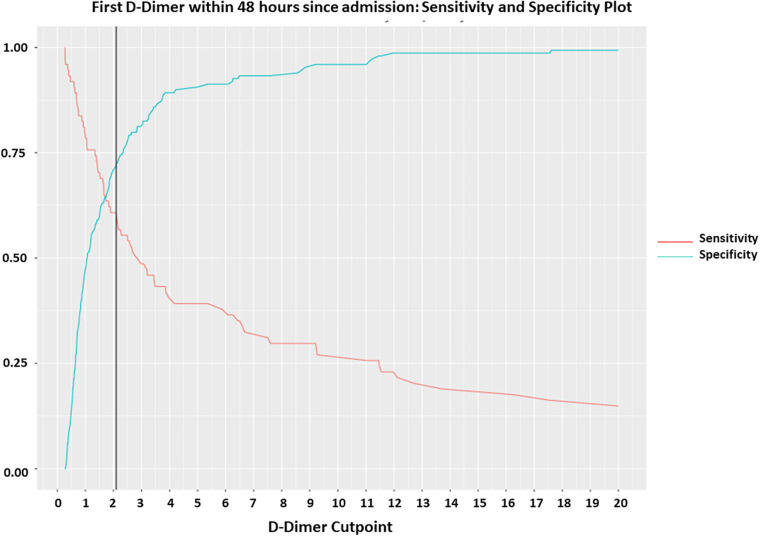
Optimal cut off of initial D-Dimer by Youden’s J statistics. Youden index measuring the optimal cut point for initial D-Dimer as a differentiating marker when equal weight is given to sensitivity and specificity for the values in the cohort. The optimal cut-point for the initial D-Dimer within 48 h since admission to predict mortality was found to be at 2.1 g/ml at a sensitivity of 0.61, specificity 0.73 and AUC 0.71.